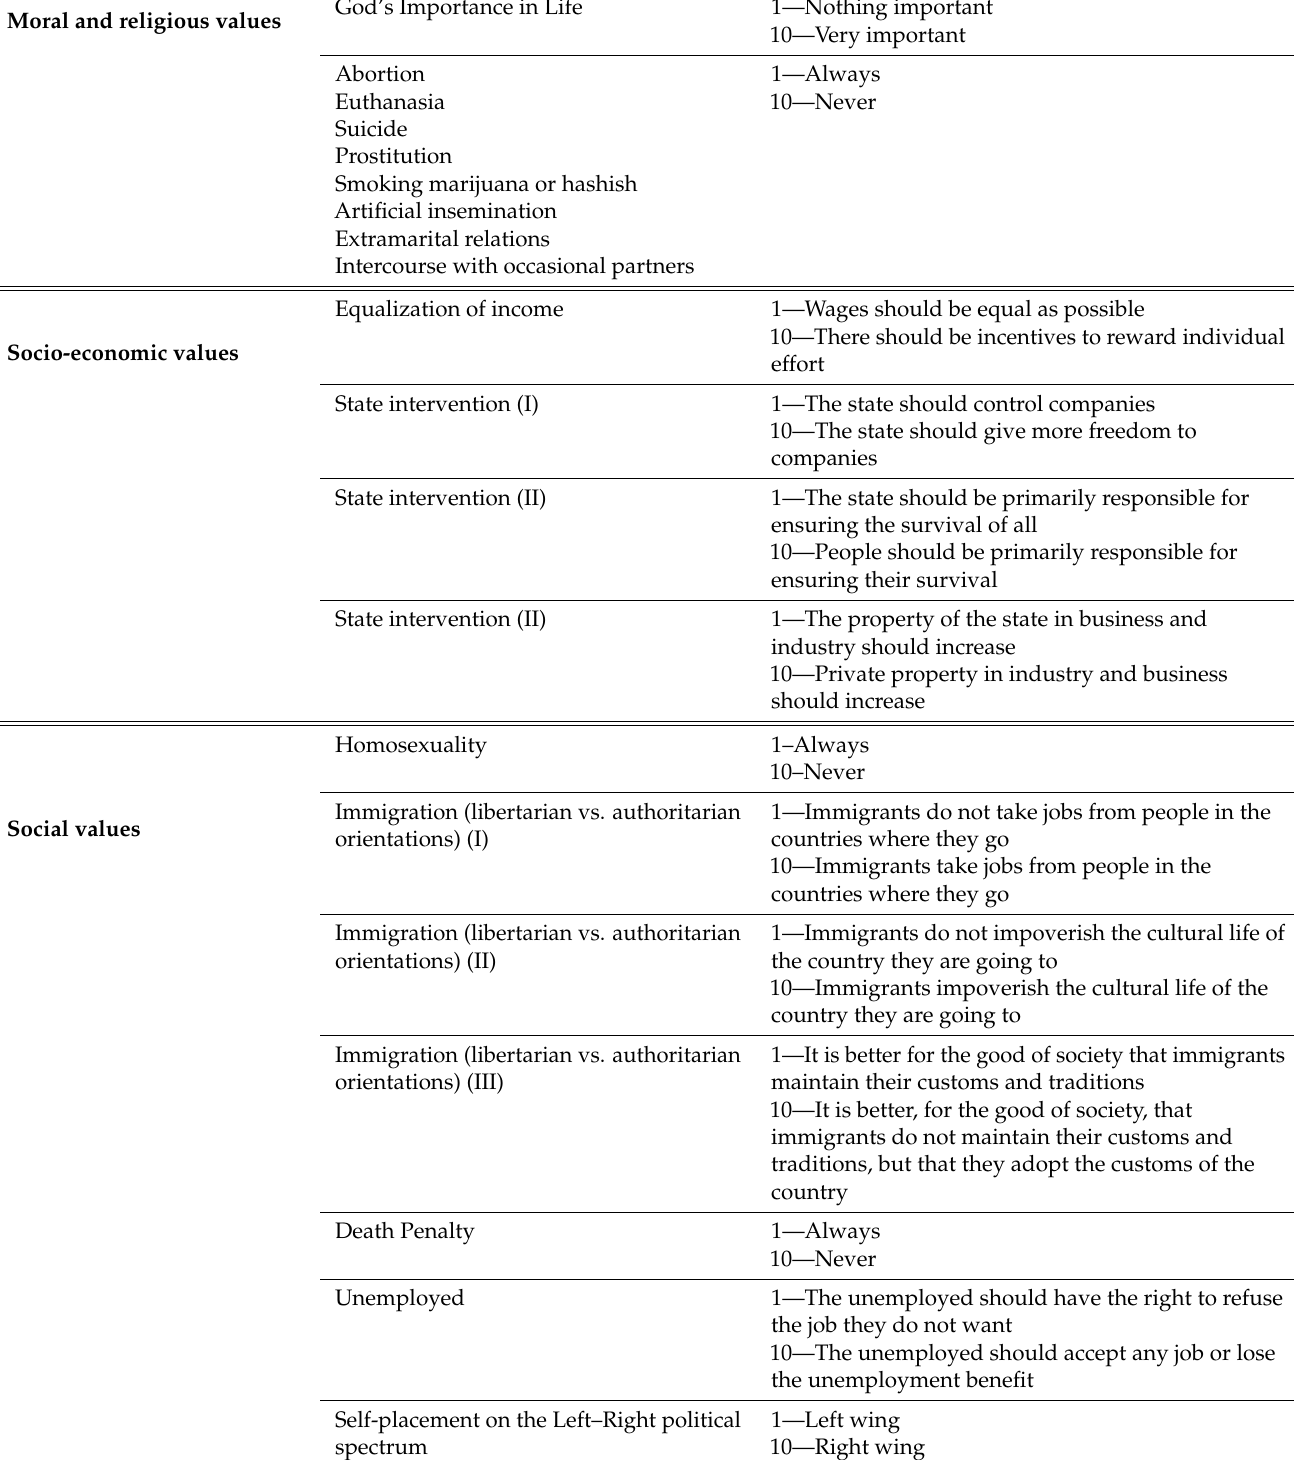
Table 1. Categorization of the application of the questionnaire to measure the left–right political scale. Moral and religious